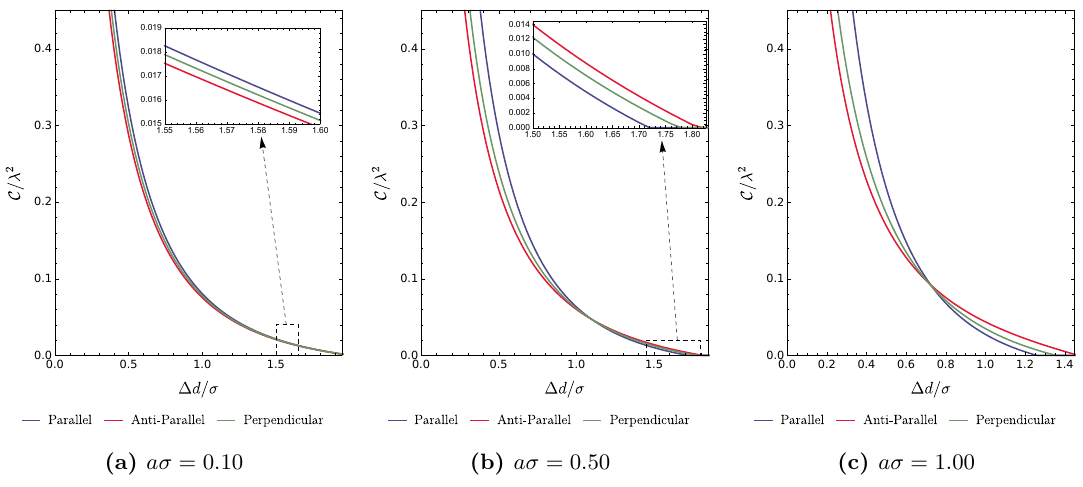
Figure 11. The plots of the concurrence vs ∆ d/σ for aσ = { 0 . 10 , 0 . 50 , 1 . 00 } in the left-to-right order with fixed ∆ z/σ = 0 . 50 and Ω σ = 0 . 10 . In each plot, a comparison of different scenarios is implemented via different colored solid